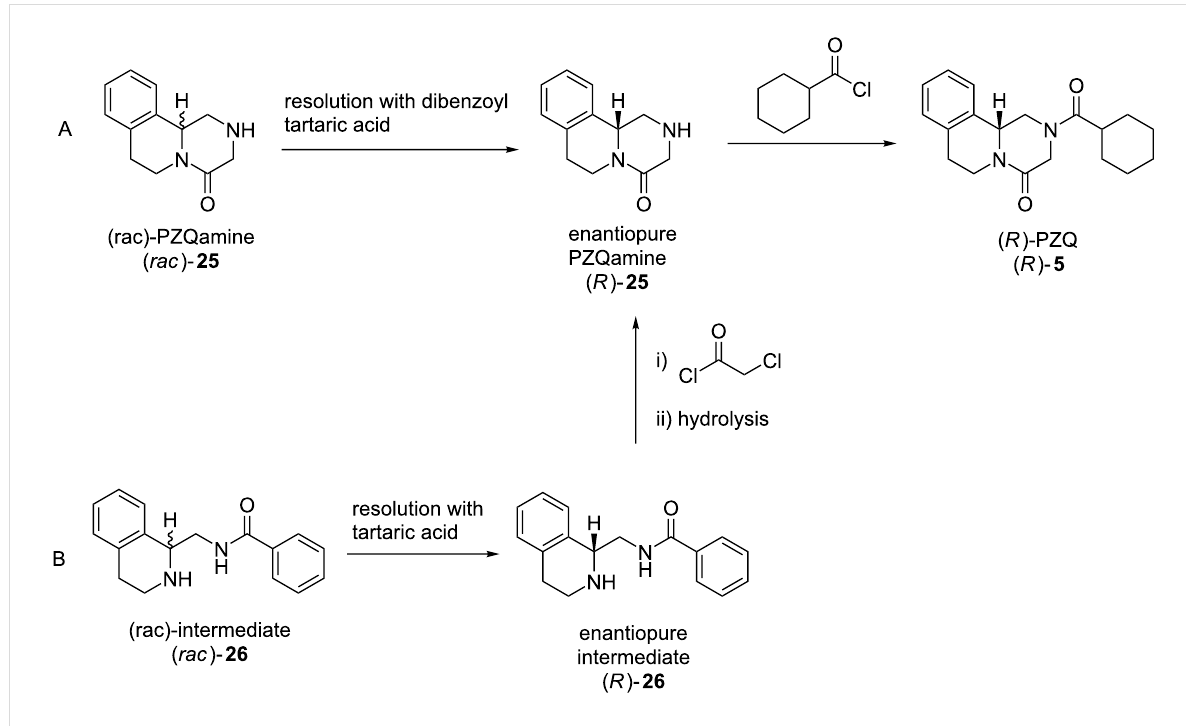
Figure 6: Two resolution approaches to enantiopure PZQ ( R )- 5 discovered through A) open science and B) contract research